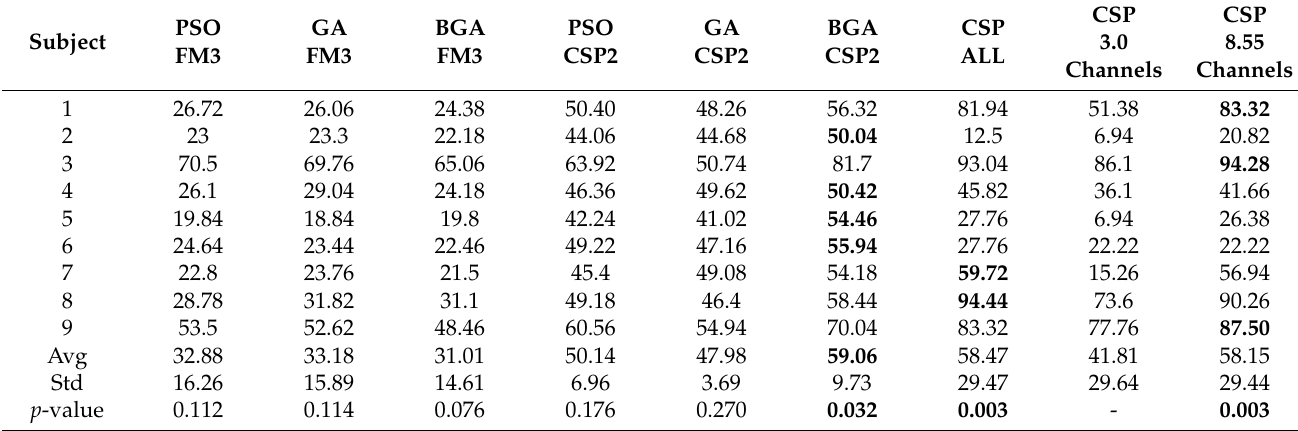
Figure 14. The best results of different methods for feature selection (along with feature extraction, feature reduction, channels, etc.) on two channels, 8 and 12, by combining different select bands. Table 19. Examining the best kappa different methods for selecting features (along with feature extraction, reducing features and channels, etc.) on three channels, 8, 10, and 12, by combining different selected